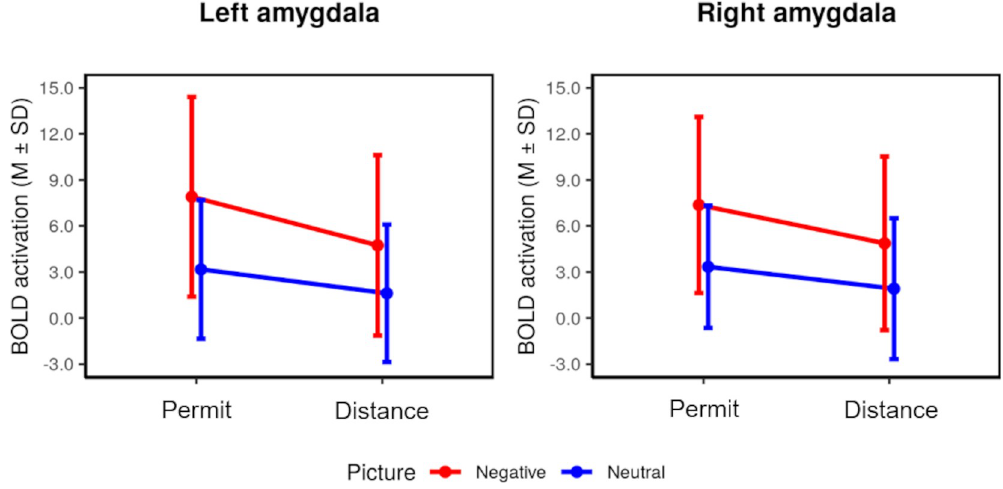
Fig 2. Summary statistics for the activation of the amygdala ROI during the stimulation phase (concurrent effects, timepoint 1).